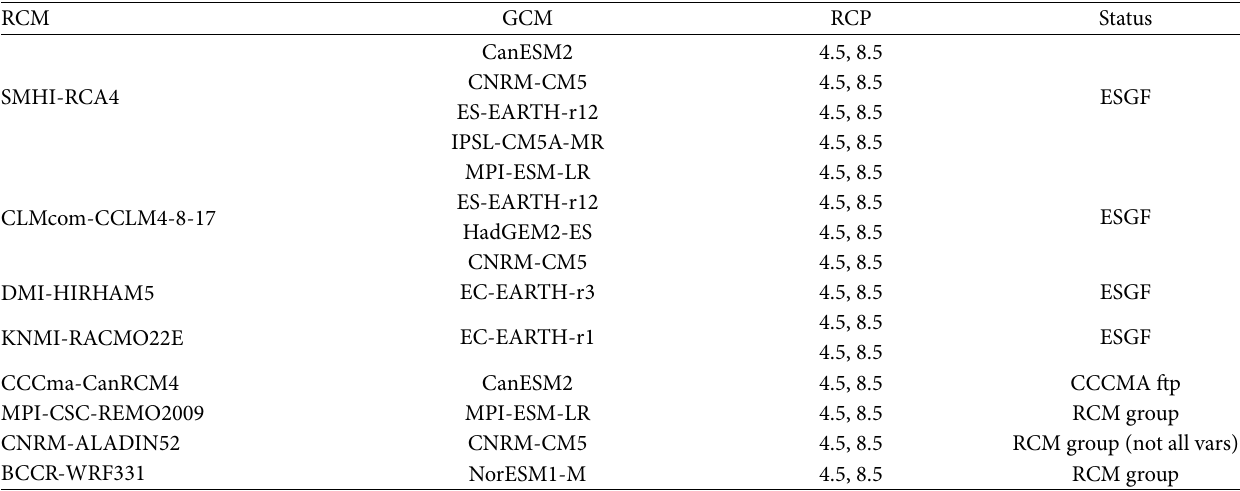
Table 1: Fourteen RCMs simulations of CORDEX-Africa project phase 2 and their forcing GCMs. ESGF (Earth System Grid Federation), CCCMA (Canadian Centre for Climate Modelling and Analysis), status (Source of the data).